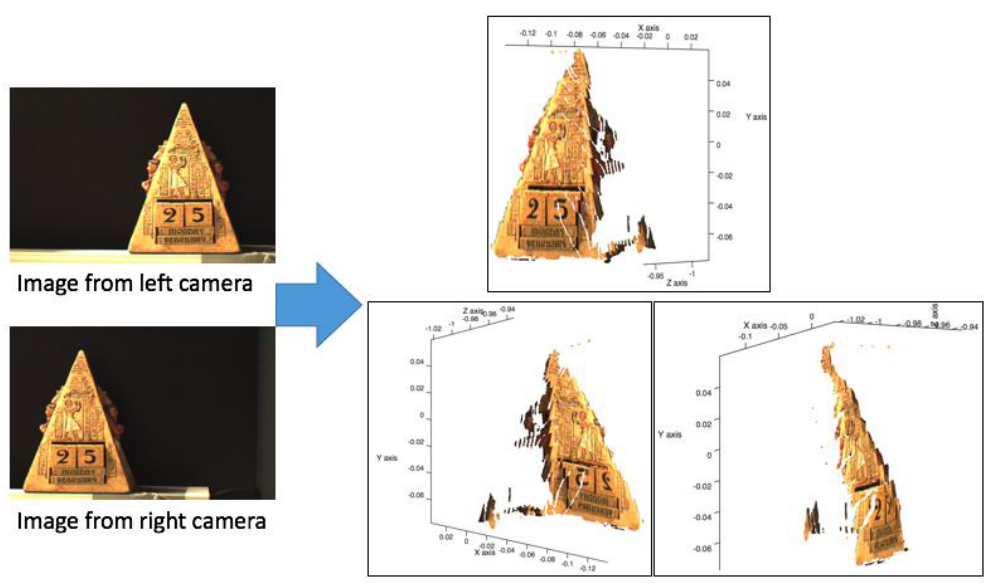
Figure 2. Example of reconstructing 2-D images to 3-D image.